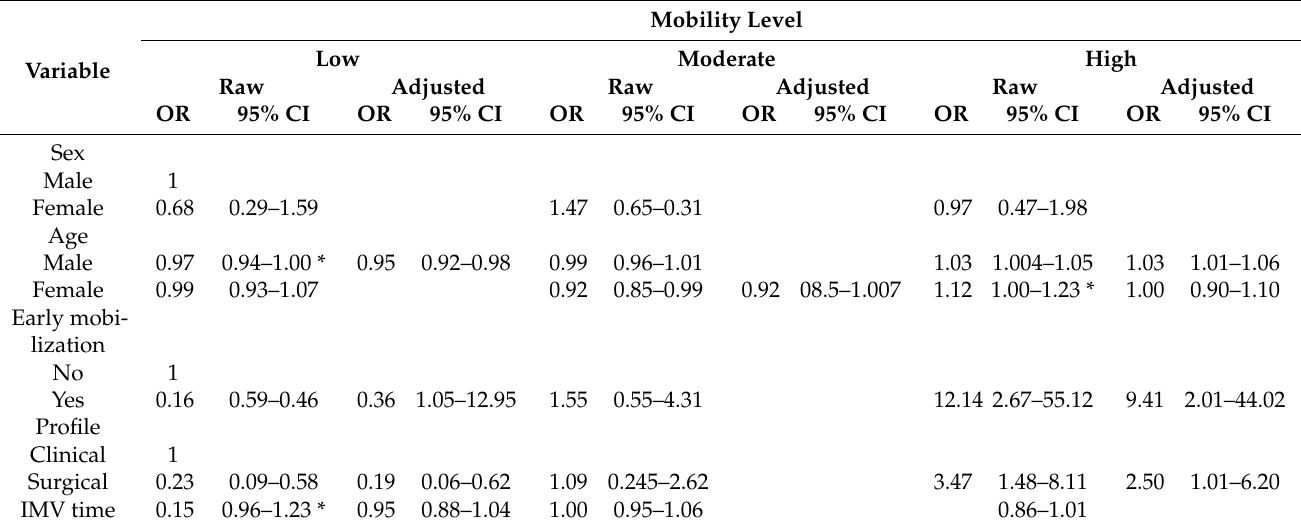
Table 2. Crude and adjusted association between factors and levels of mobility in the ICU.